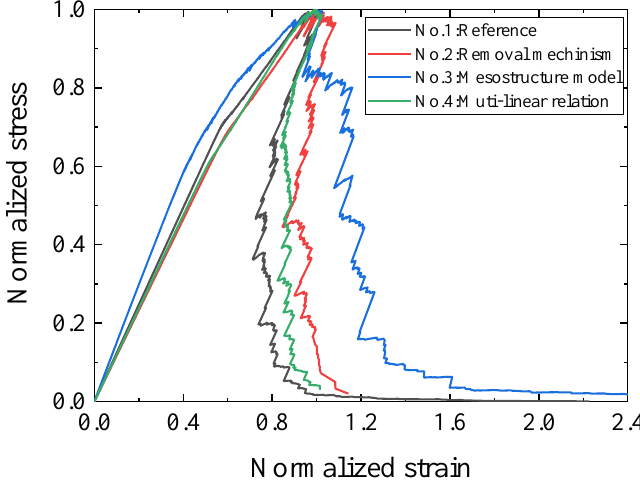
Figure 15. Normalized stress and normalized strain curve with different influence factors.